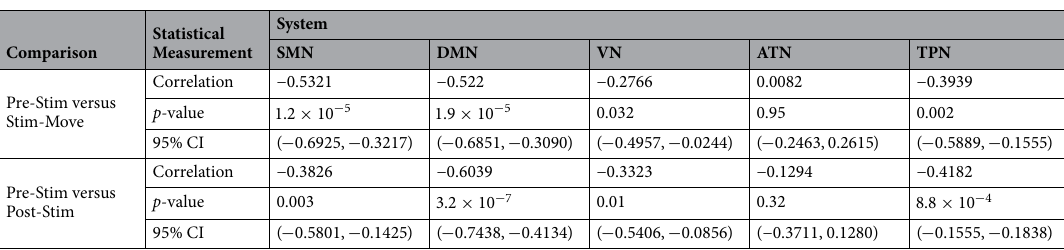
Table 2. Correlation between the magnitude of change in flexibility and tTENS